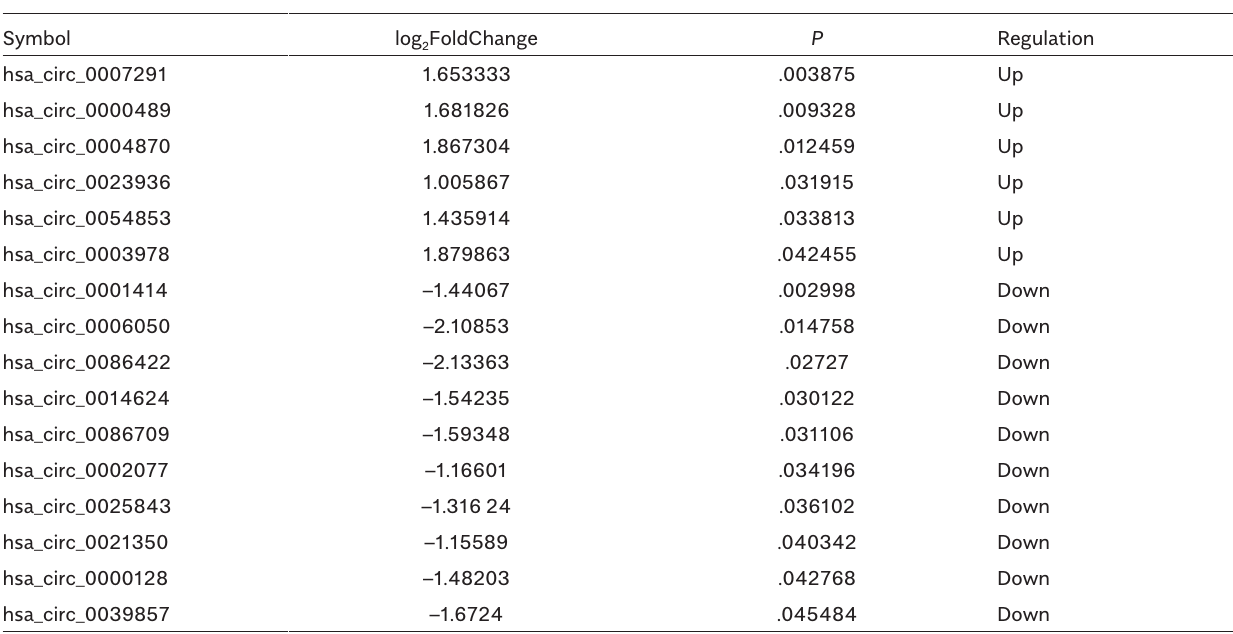
DE, differentially expressed; HCC, hepatocellular